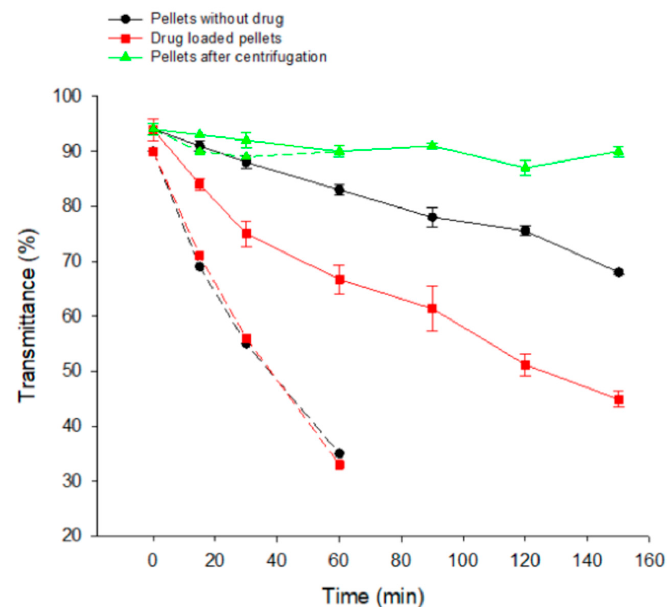
Figure 7. Transmittance (T%) vs time for pellets without drug (black circles), for drug loaded pellets (red squares) and for pellets after centrifugation (green triangles) at pH 1.2 (broken lines) and pH 6.8 (solid lines).